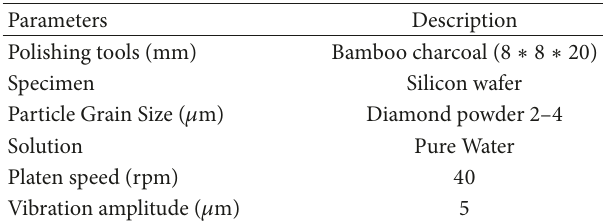
Table 1: The constant parameters of UV polishing.